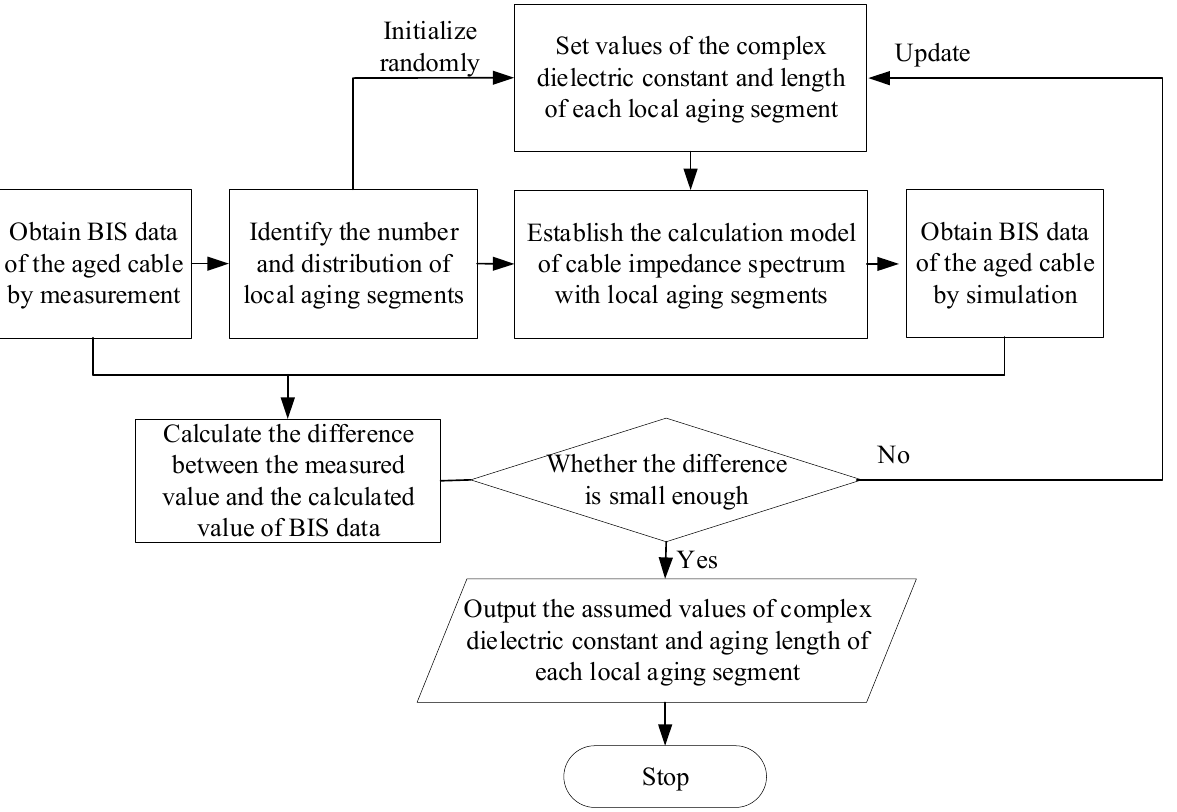
Figure 11. Acquisition procedure of the complex dielectric constant for each local aging segment based on BIS measuring combined with PSO [22].